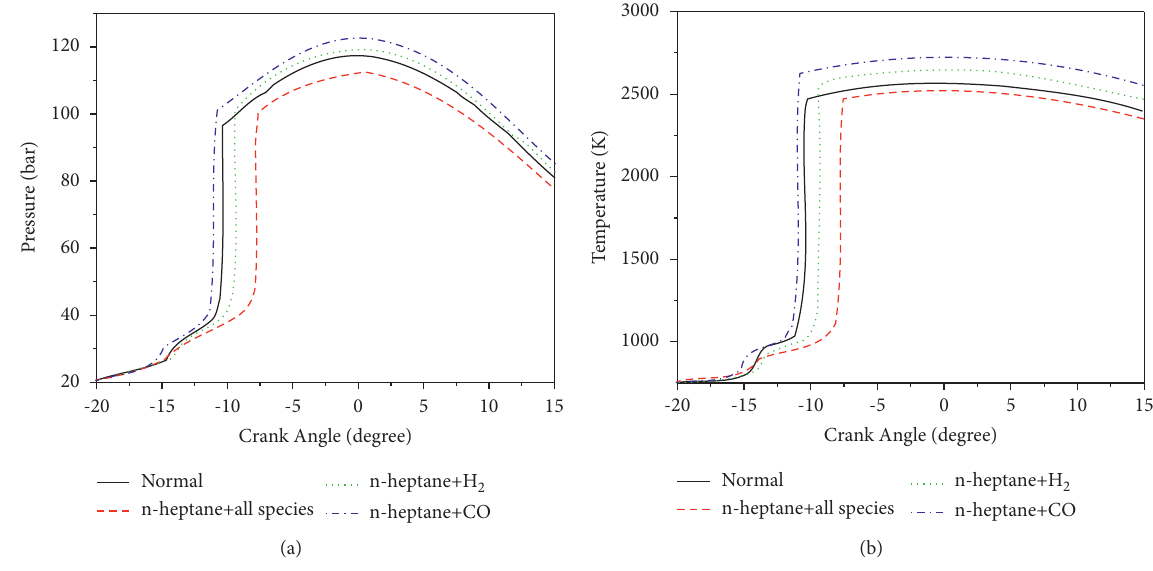
Figure 5: Comparisons of normal cylinder pressure and temperature with different reforming species.